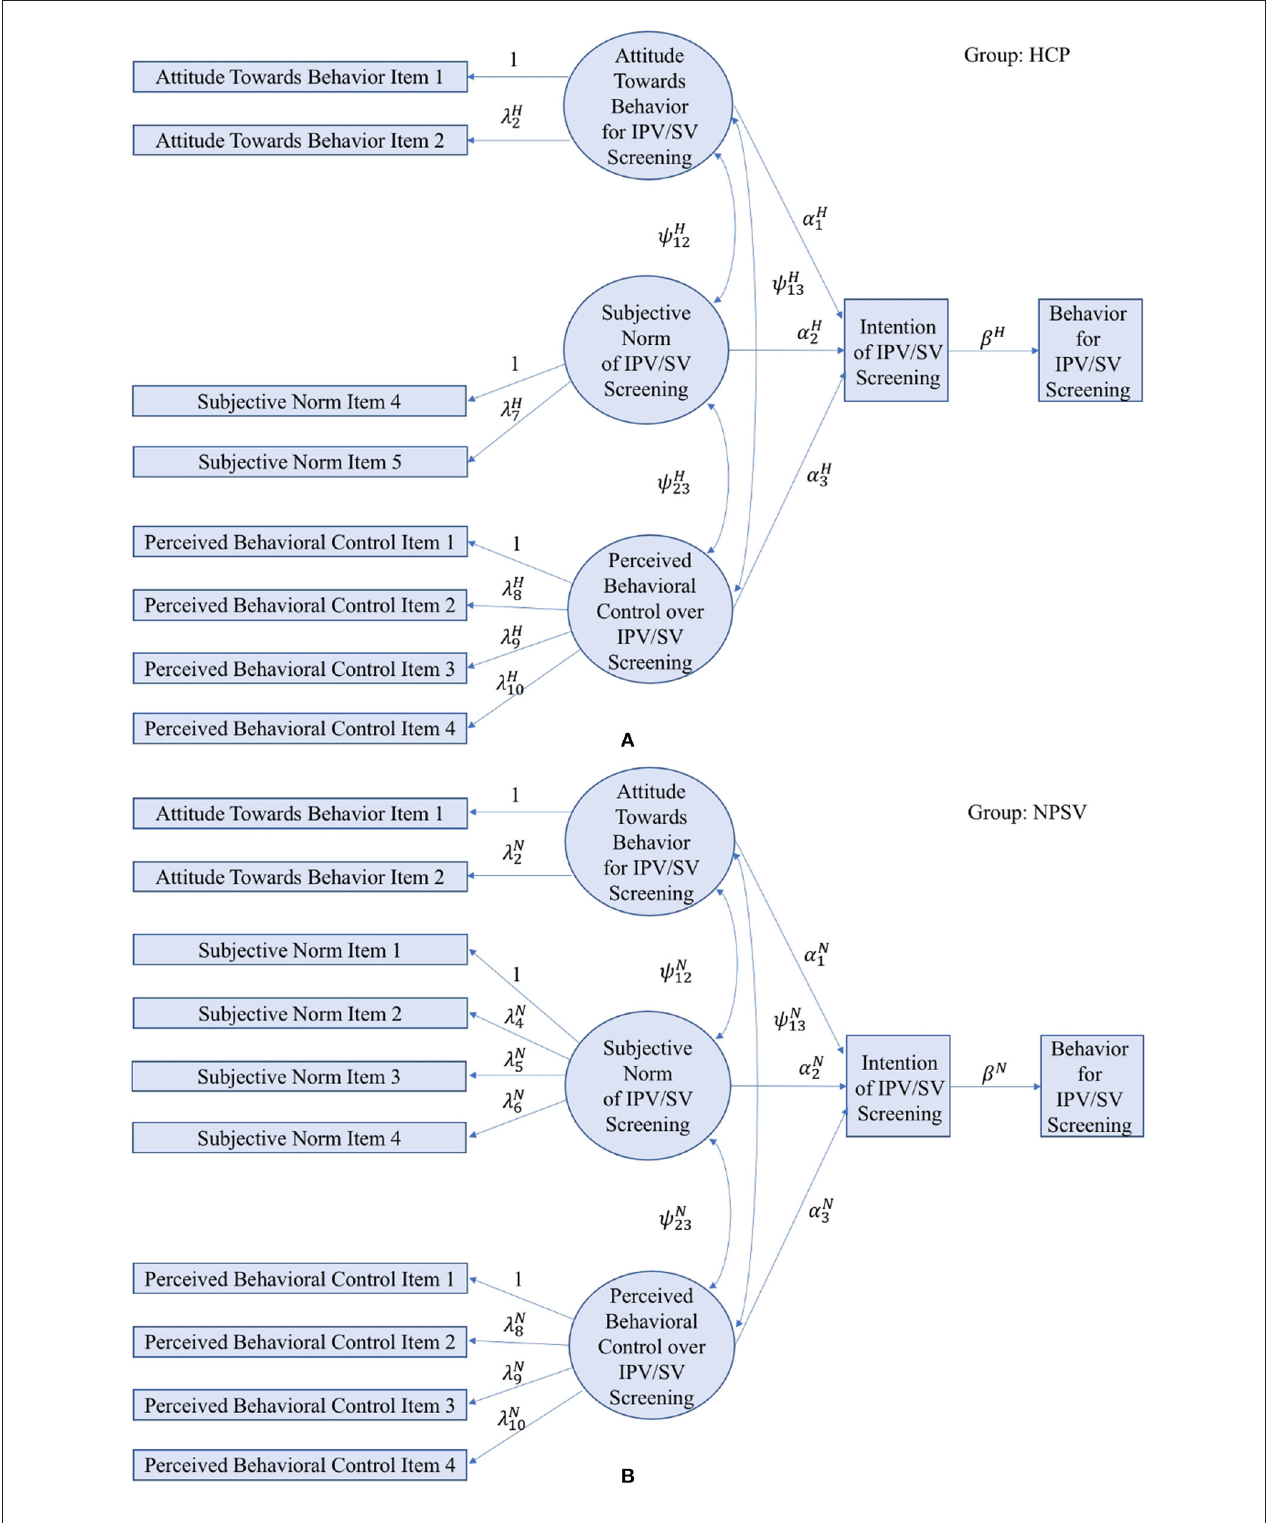
FIGURE 1 | Model specification for the multi-group SEM in the HCP study (A) and the NPVS study (B) .